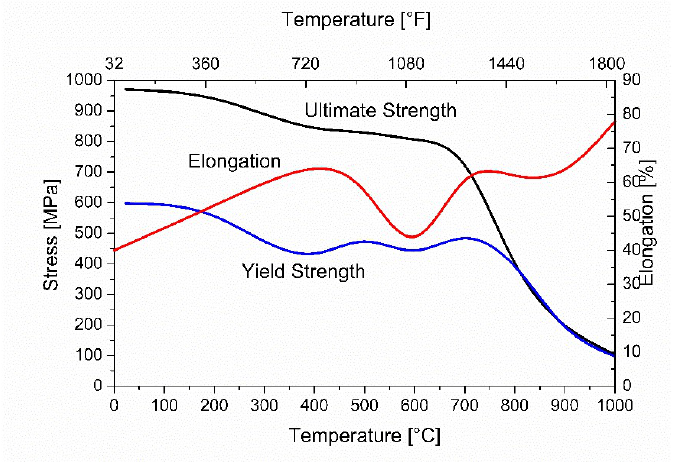
Figure 2. Yield strength, ultimate strength, and elongation results obtained from Inconel 625 tensile tests as a function of the test temperature.